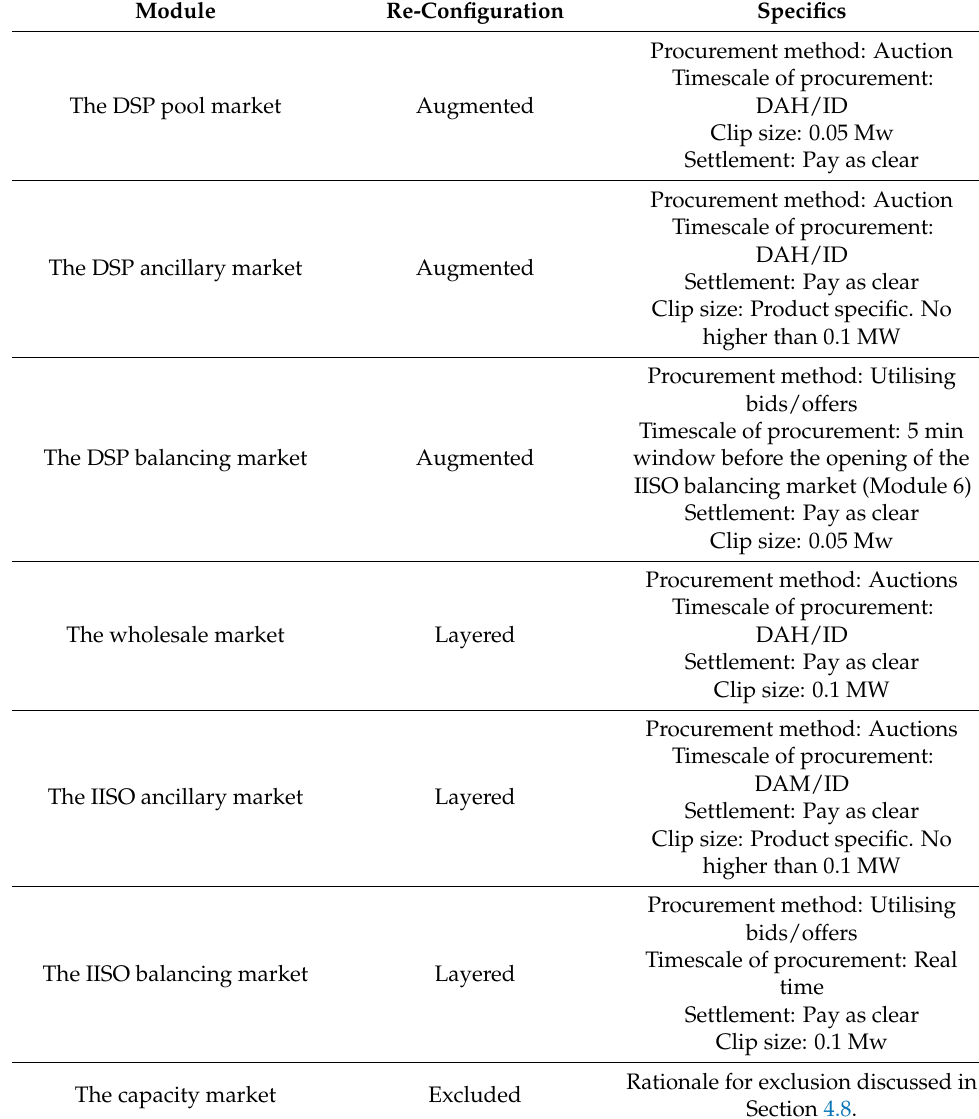
Table 3. Each module, how they were reconfigured and the specifics of the module. Authors’